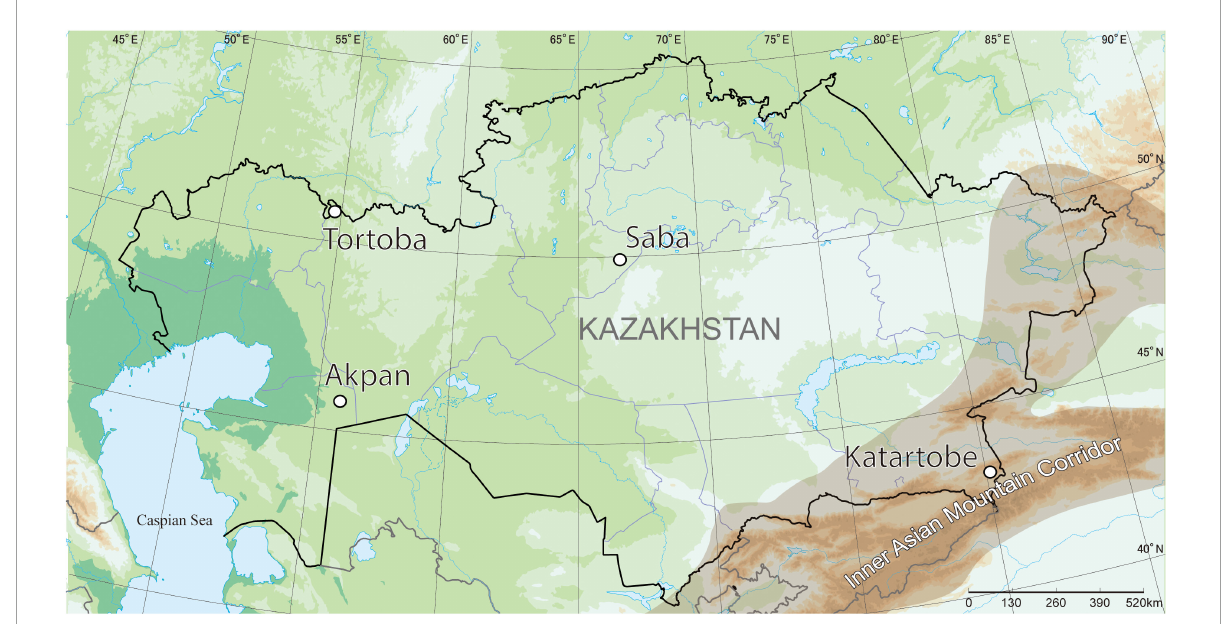
FIGURE1 Map of Kazakhstan with the location of archaeological sites discussed in the